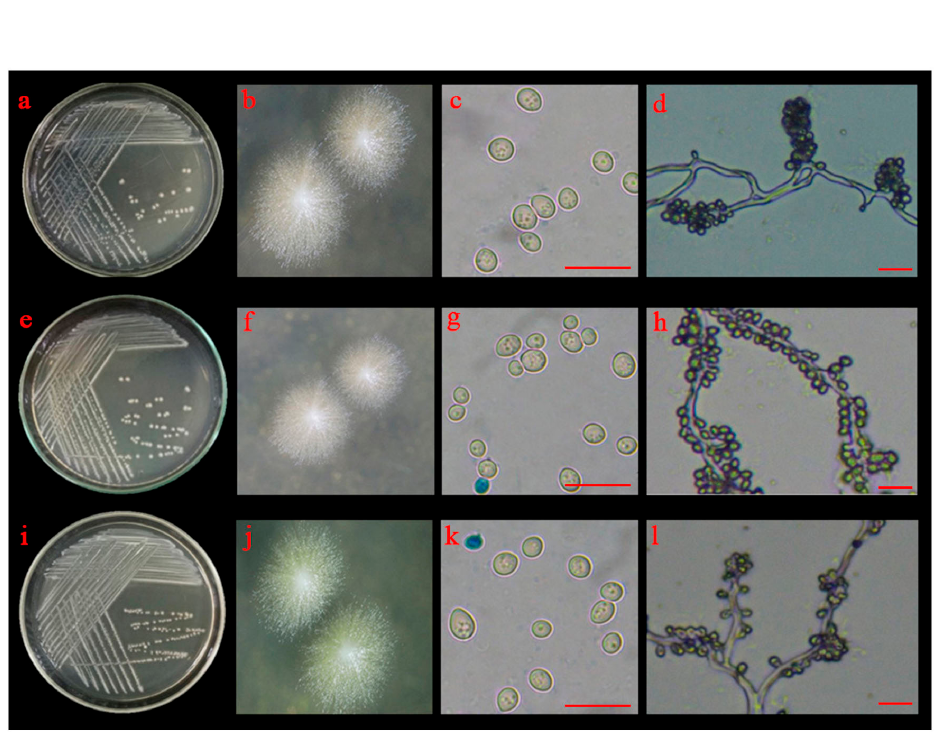
Fig. 4.(A). Morphological characteristics of YSP04; YSP14 and YSP16 isolates: colonies of YSP04 (a and b), YSP14 (e and f) and YSP16 (i and j) on 5% malt extract agar; budding cells of YSP04 (c), YSP14 (g) and YSP16 (k) isolates and blastoconidia with true hyphae of YSP04 (d), YSP14 (h) and YSP16 (l) isolates; the scale bar = 10 µm.